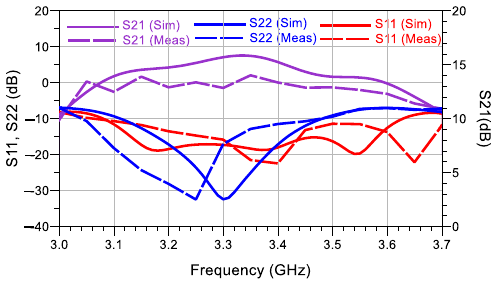
Figure 9. Measured and simulated scattering parameters of the proposed